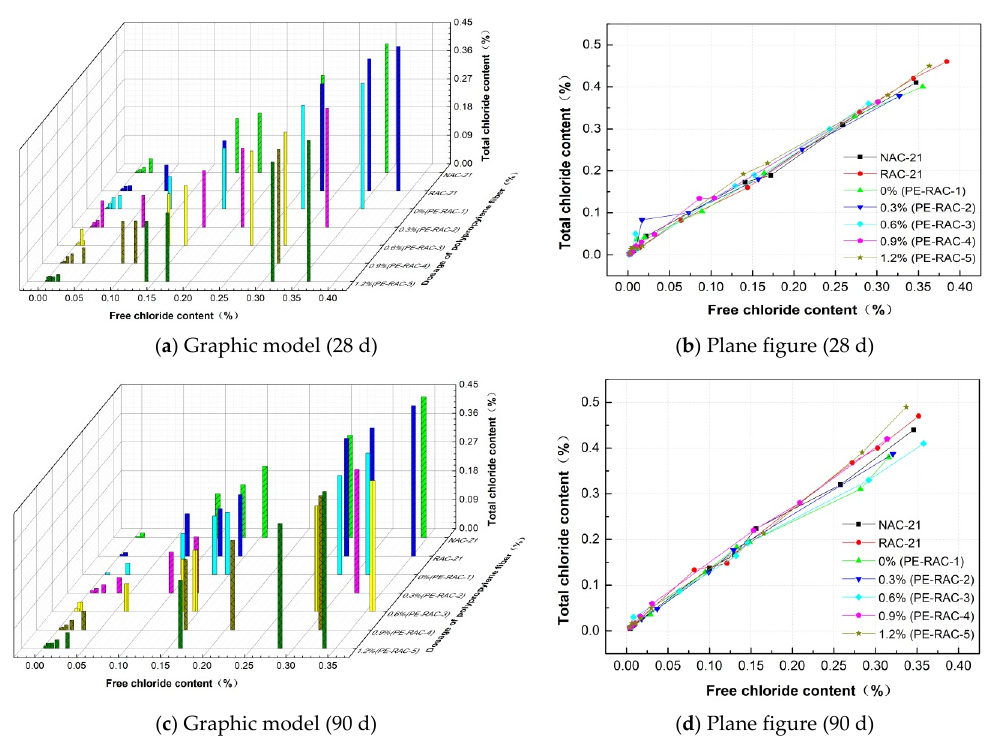
Figure 8. Relationship between free chloride ion concentration and total chloride ion concentration.